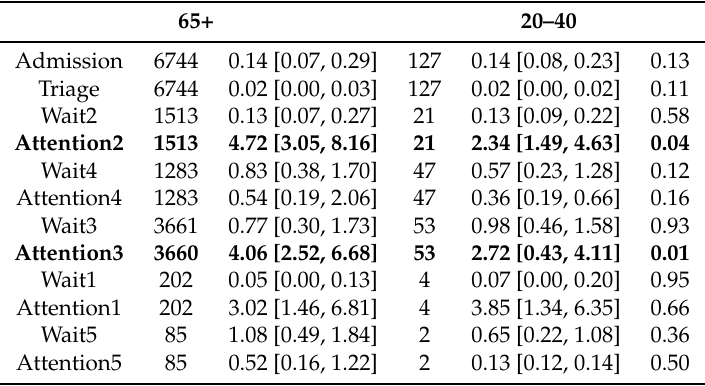
Figure 12. Emergency Room Flow discovered for patients from 20 to 40 years old. Highlighted Nodes show statistical significance in comparison with patients aged 65+ years. Table 5. Analysis of Statistical Significance between the 65+ and 20–40 age groups (Interquartile range in hours). Bold rows indicate statistical